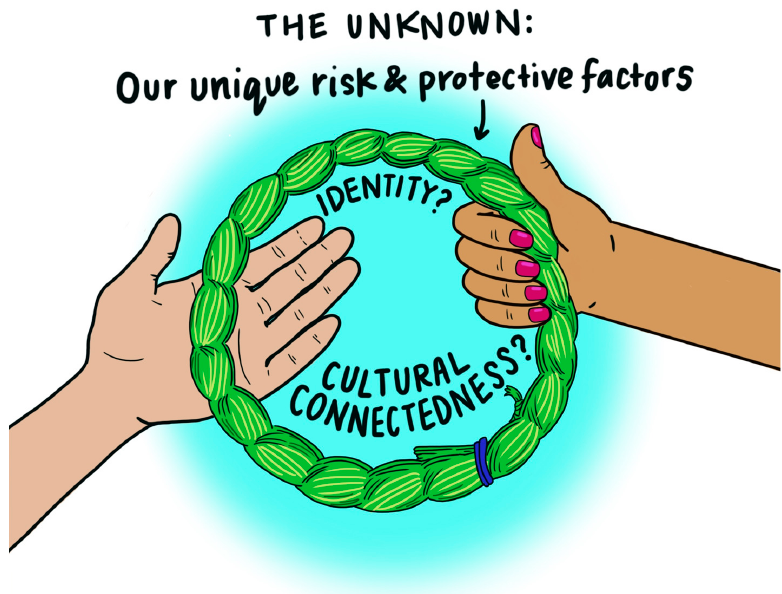
Figure 3. Hands from two different women hold a braid of sweetgrass representing where one may find unique protective factors among Native young women. See I.D. 3 in Appendix A.